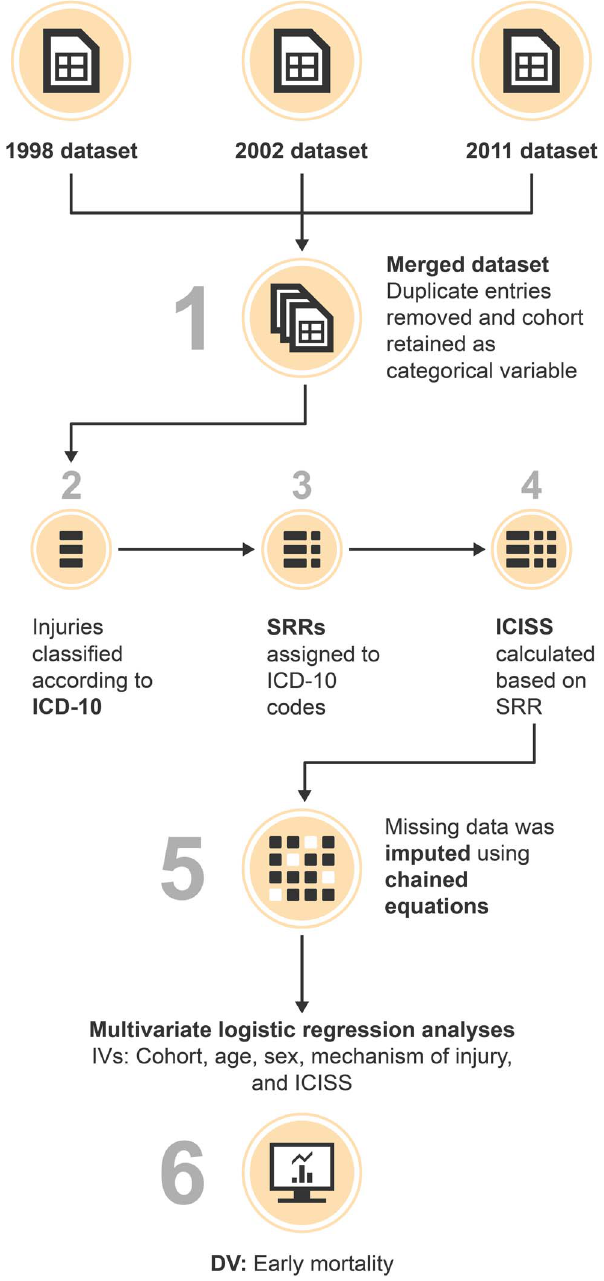
Figure 1. Flowchart providing a simplified outline of the study process. Abbreviations: DV Dependent Variable, ICD International Classification of Disease, ICISS ICD-derived Injury Severity Score, IV Independent Variables, SRR Survival Risk Ratio.